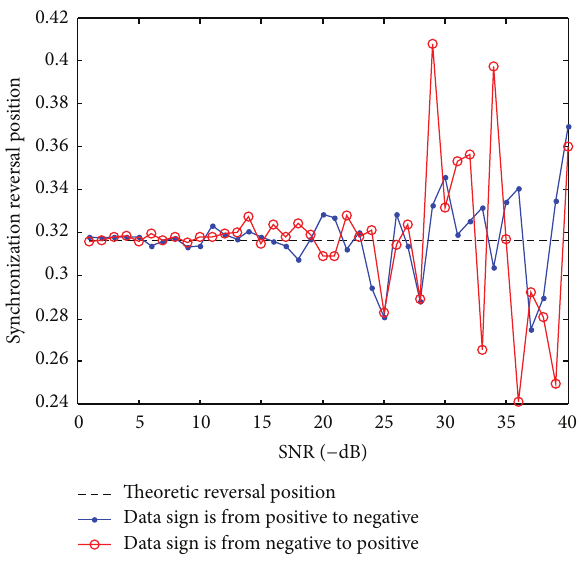
Figure 5: The estimated reversal position change with changing SNR.